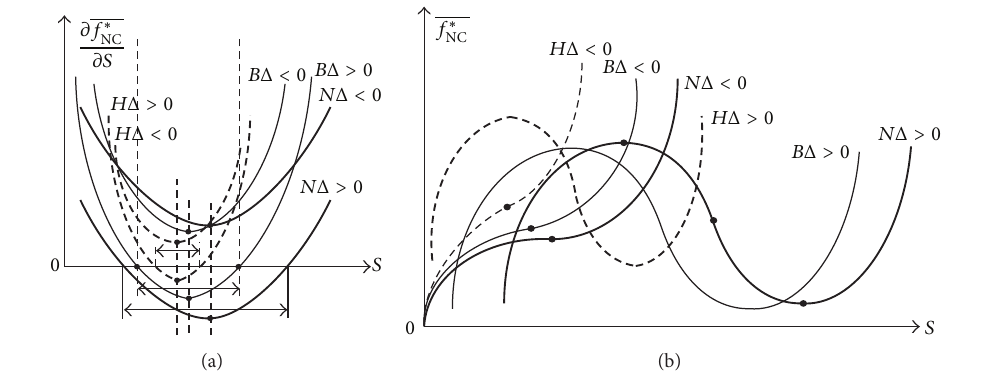
Figure 2: Relations between 𝜕𝑓 ∗ NC /𝜕𝑆 , 𝑓 ∗ NC , and 𝑆 .